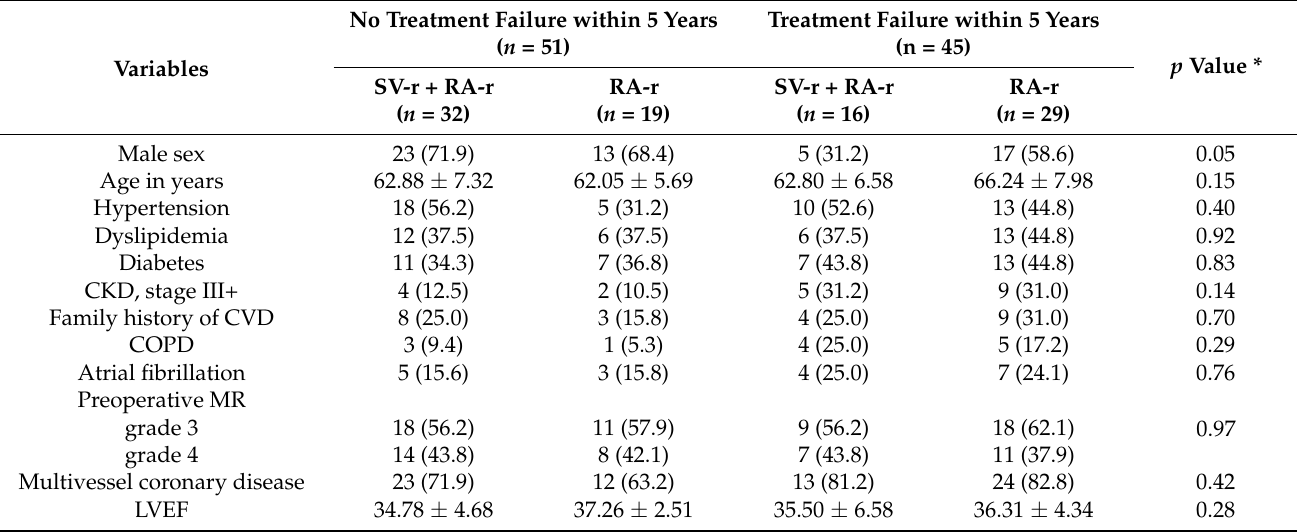
Table 1. Baseline patients’ characteristics of SV-r + RA-r vs. RA-r, stratified by treatment